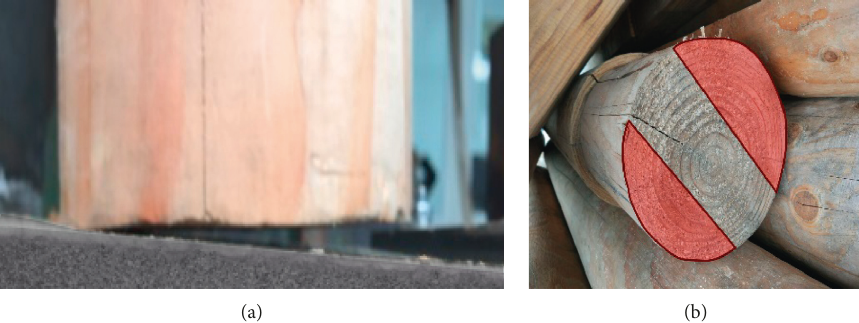
Figure 8: Column foot behaviour in wood frame ZGW188. (a) Uplift. (b) Edges with compression deformation.